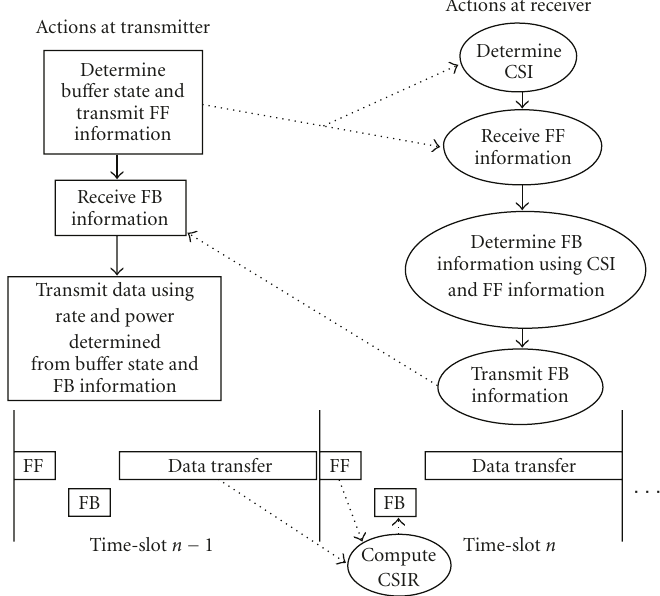
Figure 4: Summary of the main steps involved at the transmitter and receiver in implementing the proposed joint FF-FB architecture.